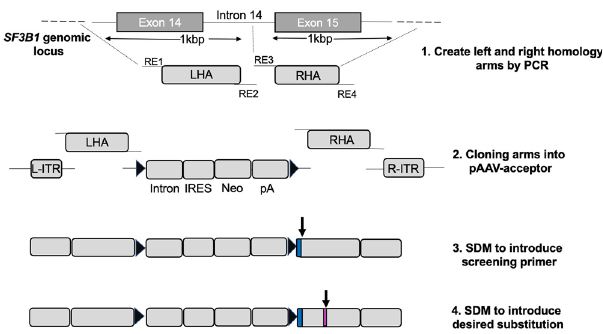
Fig. 1 Schema for creation of the rAAV-donor. Step 1: left (LHA) and right (RHA) homology arms were created by PCR from human genomic DNA template using PCR primers tailed with restriction enzyme sites (REs; RE 1, 2 for LHA and RE 3, 4 for RHA) for subsequently cloning into the pAAV acceptor. Step 2: The left and right homologous arms were digested and sequentially cloned into the pAAV-SEPT-Acceptor plasmid, which has been built with a Neomycin (Neo R ) gene-trap cassette. Step 3: The extra 20 bp from upstream exon (primer 2 sequence) was introduced in the beginning of the RHA of the pAAV-SEPT-Acceptor by site-directed mutagenesis (SDM). Step 4: The desired substitution (K700E mutation) was introduced in the right arm of the pAAV-SEPT-Acceptor by SDM (shown in